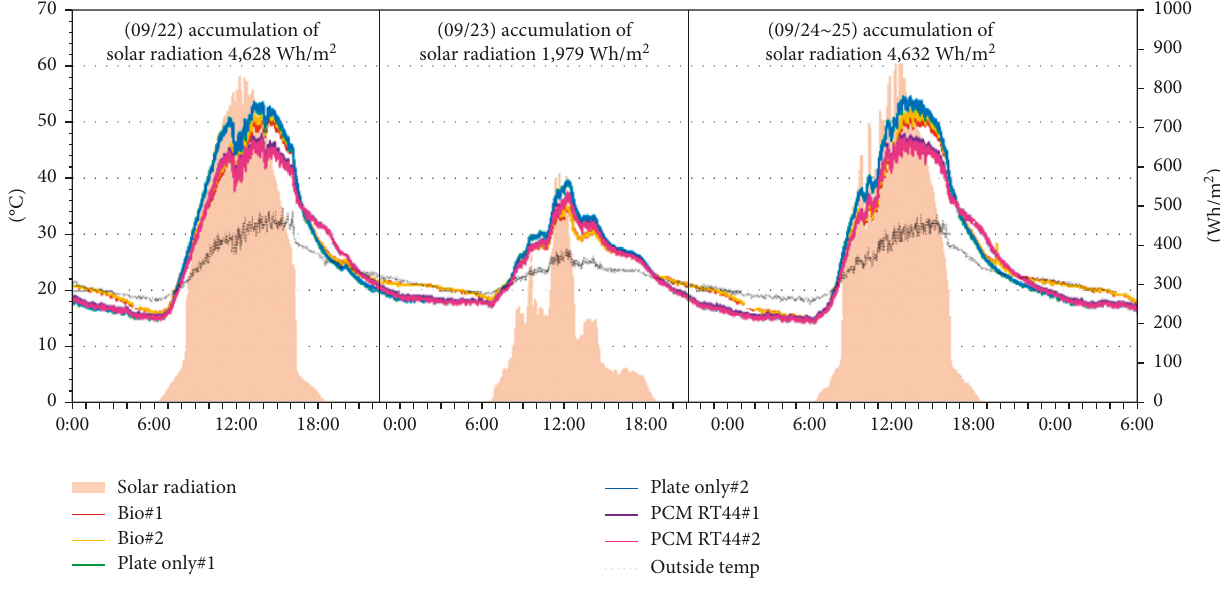
Figure 3: Ambient conditions of Test 1.